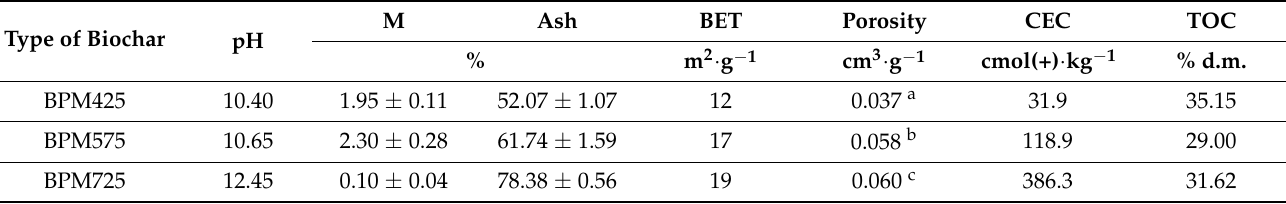
Table 6. Selected properties of